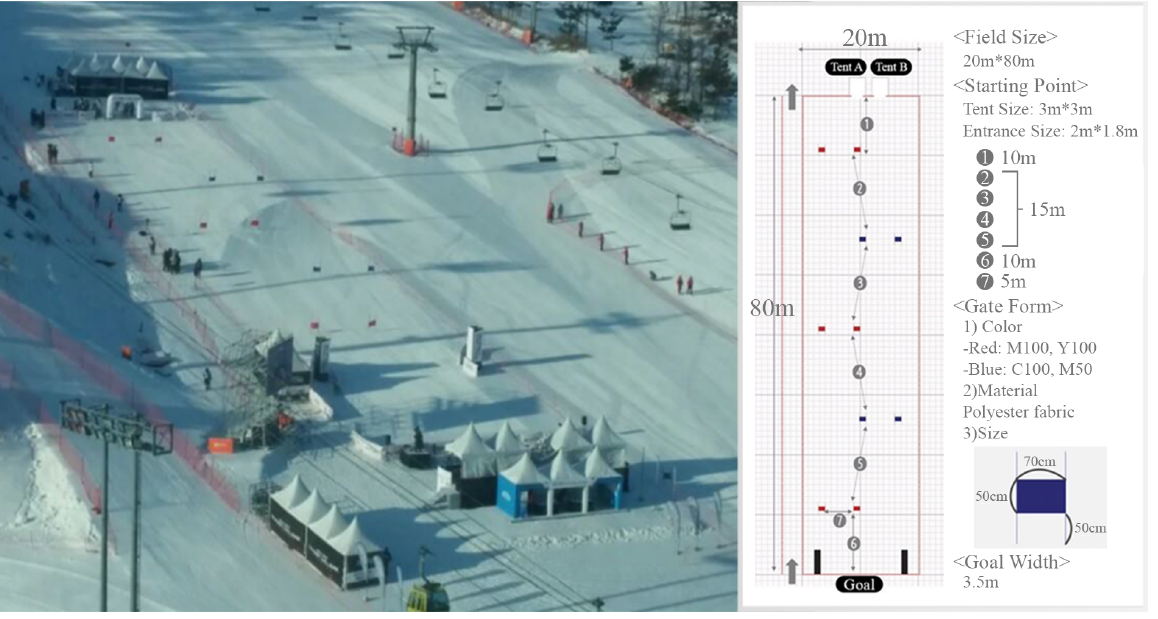
Figure 15. A view of the slope ( left ) and a plan view ( right